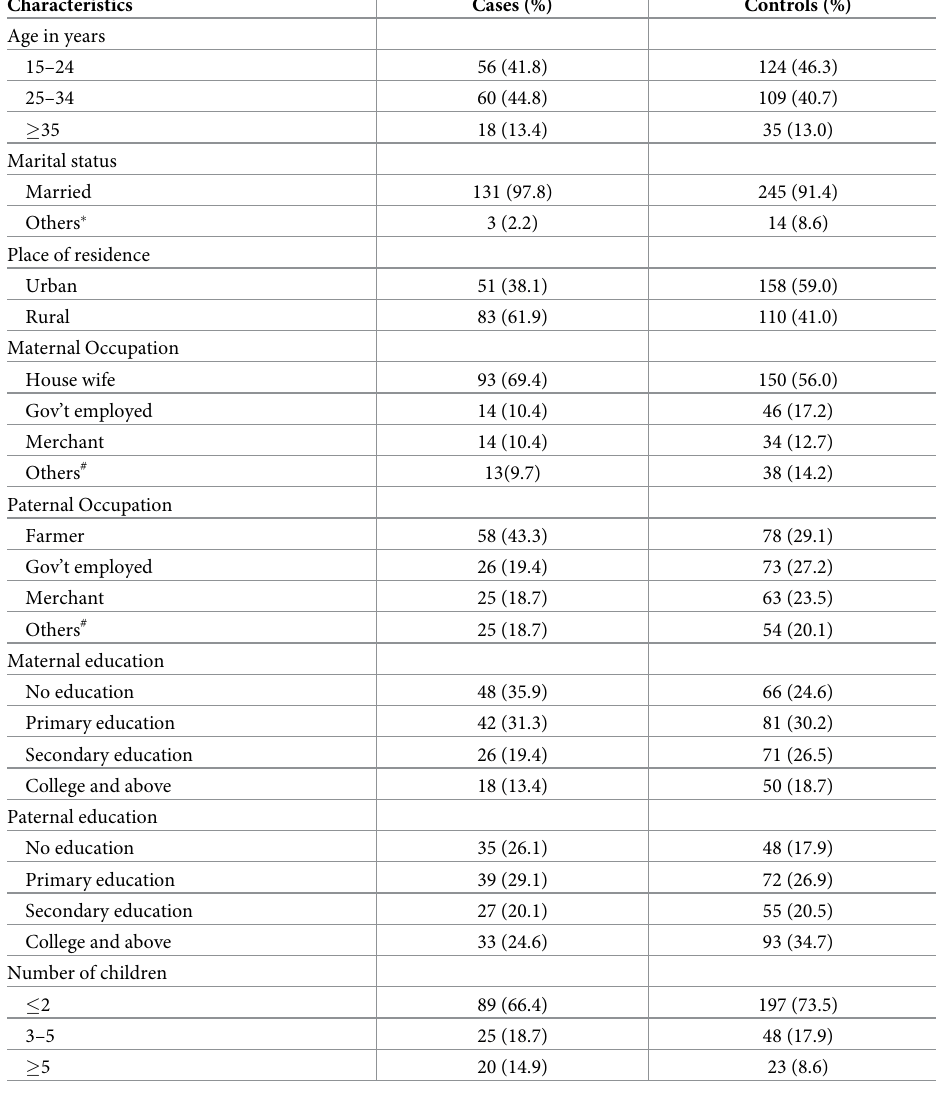
Table 1. Socio-demographic characteristics of mothers who gave live birth in Guji and Borena Zones selected Public Hospitals, Southern Ethiopia, 2021.